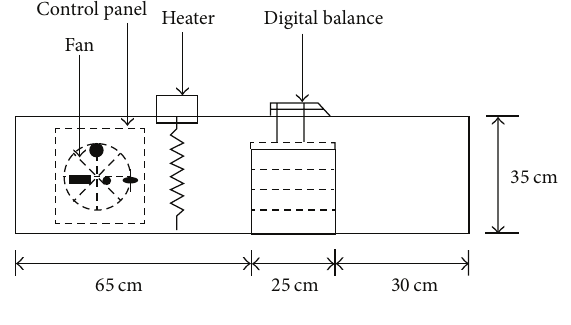
Figure 1: Scheme of the thin-layer drying equipment